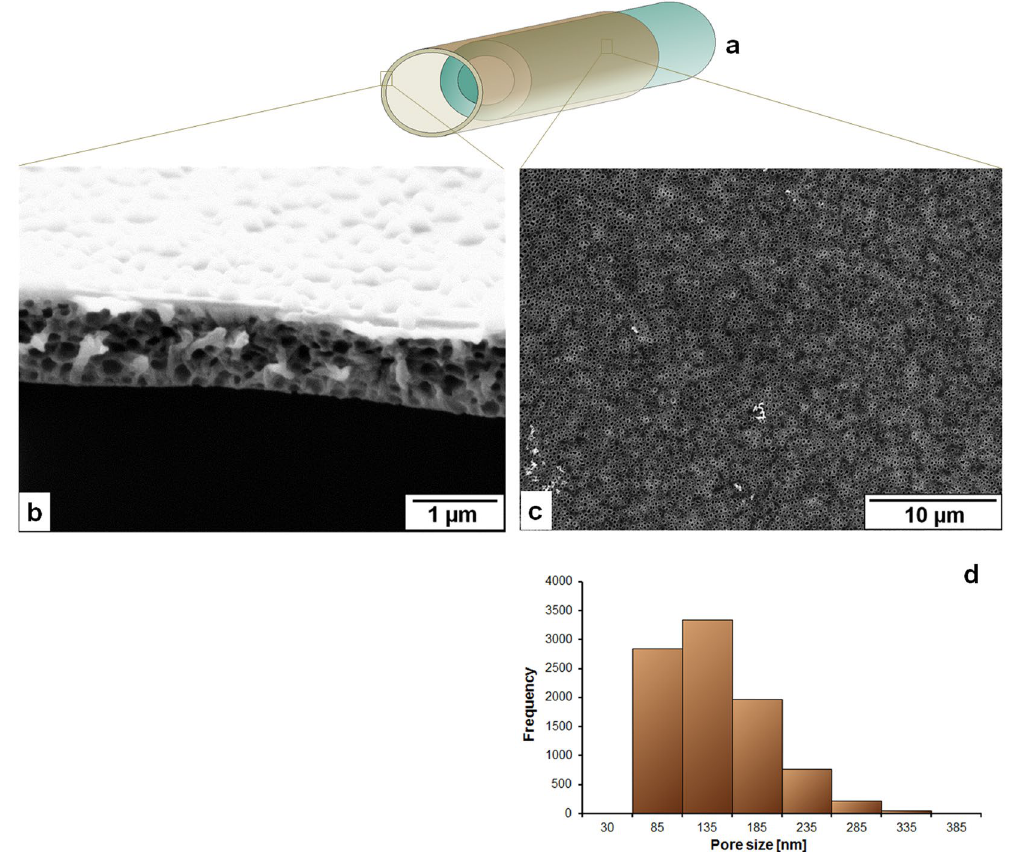
Figure 5. Film forming solution: 12% Styro Clear ® GH 62 in THF (Group 3 in Table 1); ( a ) A schematically drawn double layer hollow fiber where the macroporous outer layer encircles the support layer hollow fiber, ( b ) Cross sectional view of the porous film under scanning electron microscope (SEM), ( c ) Surface picture of the porous layer taken by SEM, ( d ) pore size distribution [9206 number of pores in 1.09 × 10 3 µ m 2 of the measured area] of the surface of the film forming layer measured by IMS V15Q4 (Imagic Bildverarbeitung AG, Glattbrugg,